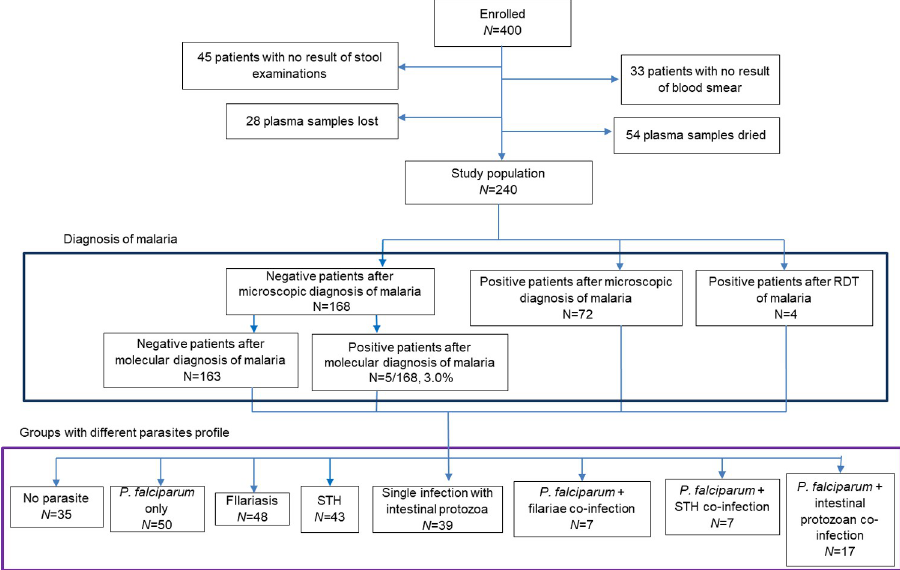
Fig 1. Flow chart of the study population. This figure represents a flow chart for enrolment of the study population, followed by the number of individuals found with malarial infections in the study population and absolute frequencies in each group with different parasitic profiles. https://doi.org/10.1371/journal.pntd.0010308.g001 individuals, respectively, and intestinal protozoan monoinfection was detected in 39 (16.3%) individuals. A . lumbricoides (14.6%; 35/240), T . trichiura (13.7%; 33/240), B . hominis (36.2%; 87/240), and E . histolytica/dispar (7.1%; 17/240) were the most frequently detected intestinal parasites; G . duodenalis and S . stercoralis were each found in only 5/240 (2.1%) samples. Schis- tosoma species were not detected in any of the samples. The rates of P . falciparum /STH and P . falciparum /filariae co-infections were 2.9% (7/240), and that of P . falciparum /intestinal proto- zoan co-infection was 7.1% (17/240) (Table 1). The prevalence of parasitic infection of any type was highest in adults (87.7%; 114/130), fol- lowed by those aged 5-to-15 years old (87.2%; 41/47), and lowest in children less than 5 years Table 1. Distribution of the groups with different parasitic profiles according to sex, age and location. Total No parasites Filariae P . falciparum (n = 35) only (n = 50) (n = 48)